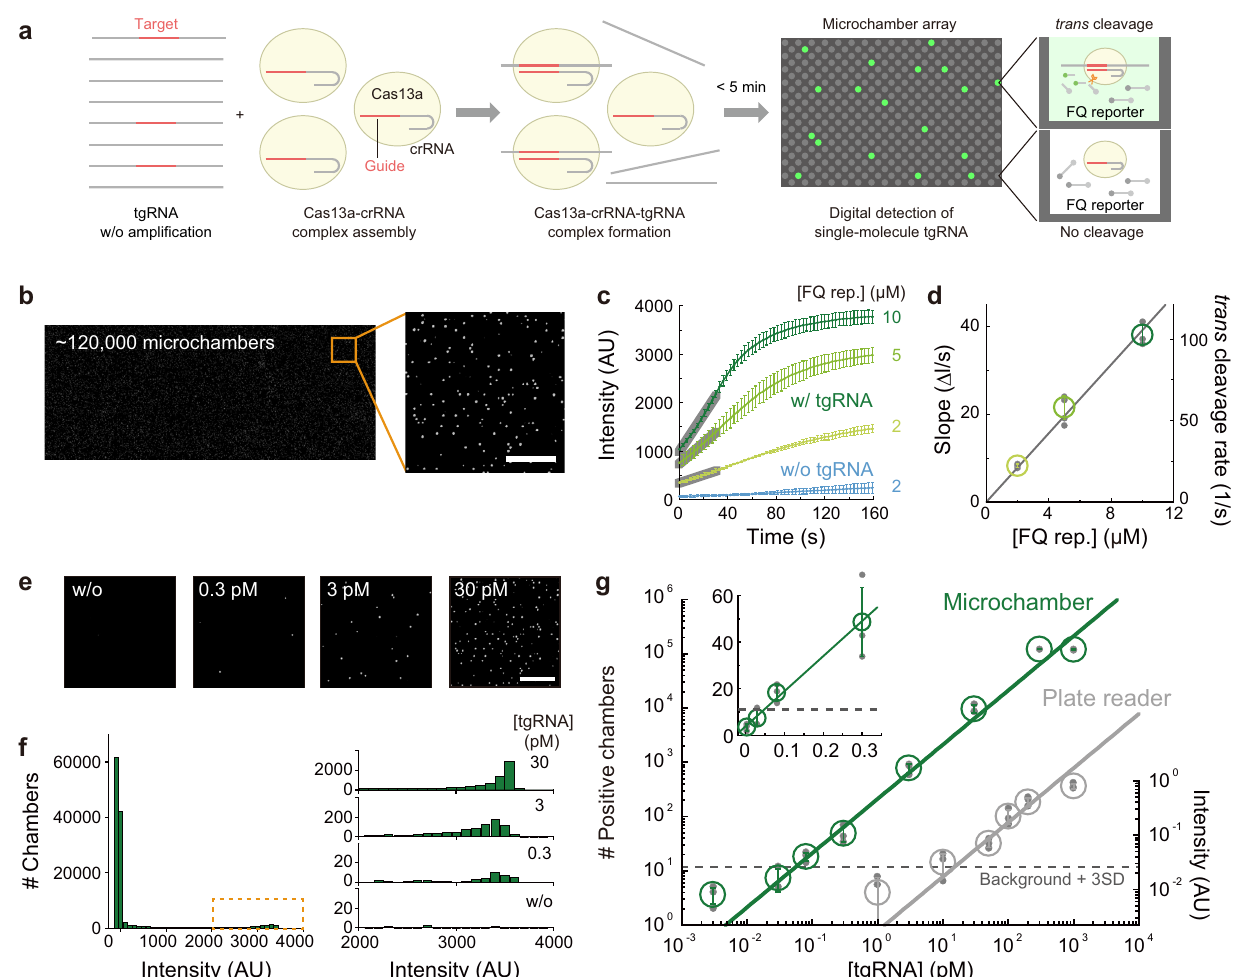
Fig. 1 Ampli fi cation-free digital RNA counting with CRISPR – Cas13 in a microchamber array device. a Schematic illustration of SATORI. LwaCas13a – crRNA – tgRNA cleaves FQ reporters, leading to fl uorescence increases in a microchamber array device. b Representative fl uorescence image obtained by SATORI in the presence of 30 pM tgRNA. Forty images acquired by tiling imaging were combined. An enlarged view of the orange square is shown on the right. Scale bar is 50 μ m. c , d Time course of fl uorescence increase ( c ) and rates of trans cleavage ( d ) by LwaCas13a – crRNA – tgRNA with different concentrations of the FQ reporter. In c , average values of ten representative traces are shown with error bars (S.D.). In d , data are mean ± S.D. ( n = 3 technical replicates). e Representative fl uorescence images obtained with different concentrations of tgRNA. Scale bar is 50 μ m. f Histograms of mean intensity values in each chamber (~120,000 chambers in the combined image). Enlarged views of the orange dotted box, with different concentrations of tgRNA, are shown on the right. g Comparison of LwaCas13a-mediated RNA detection methods in a microchamber device (SATORI, green) and a plate reader (gray), without recombinase polymerase ampli fi cation. Data are mean ± S.D. ( n = 3 technical replicates), fi tted to linear regressions. The dotted line is the value of the background mean + 3 S.D. LOD values for SATORI and the plate reader-based bulk assay were 56 fM and 11 pM,